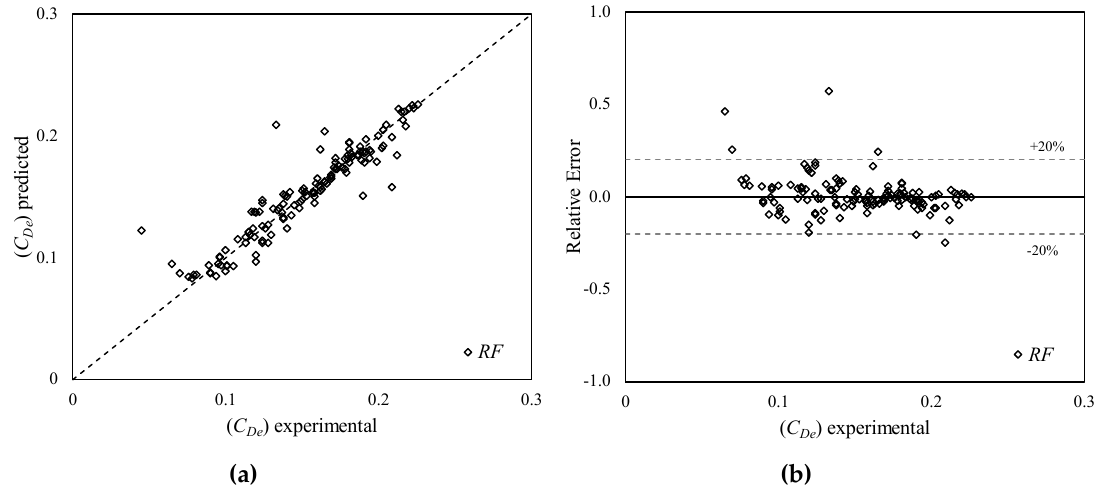
Figure 6. Model 1, RF algorithm, ( a ) predicted versus experimental results, and ( b ) relative error versus experimental results.